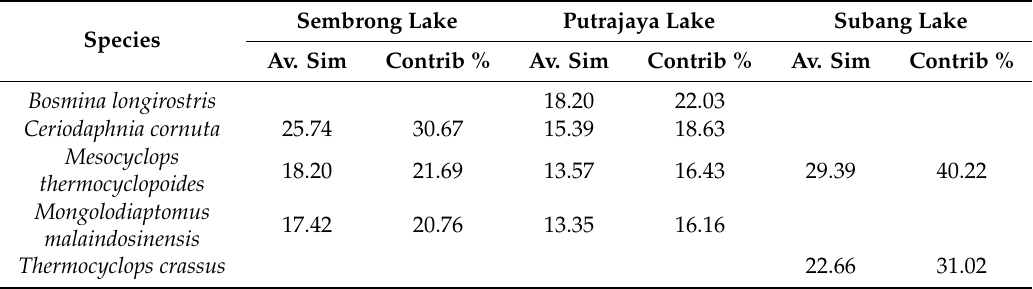
Figure 6. Shade plot of monthly variations of microcrustacean species densities (ind. L −1 ) in Sembrong, Putrajaya and Subang lakes. White spaces denote absence of the species in that specific lake during the specific month/season; depth of colour scale is linearly proportional to a fourth-root transformation of density. Inserted rectangular box (dashed line) indicates the discriminator / dominant species in each lake. Percentage contribution (%) of major microcrustacean species ( > 70%) for each lake based on similarity percentage (SIMPER) analysis. Av. Sim = average similarities, Contrib % = contribution